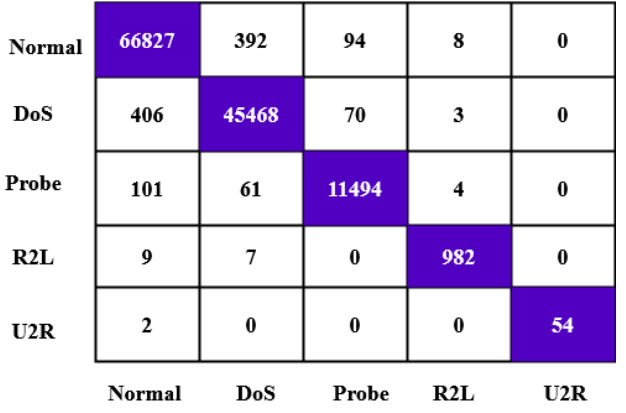
Figure 7. Confusion matrix for the NSL-KDD dataset.